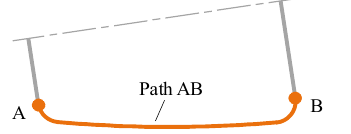
Figure 17. Path defined in post-processing.